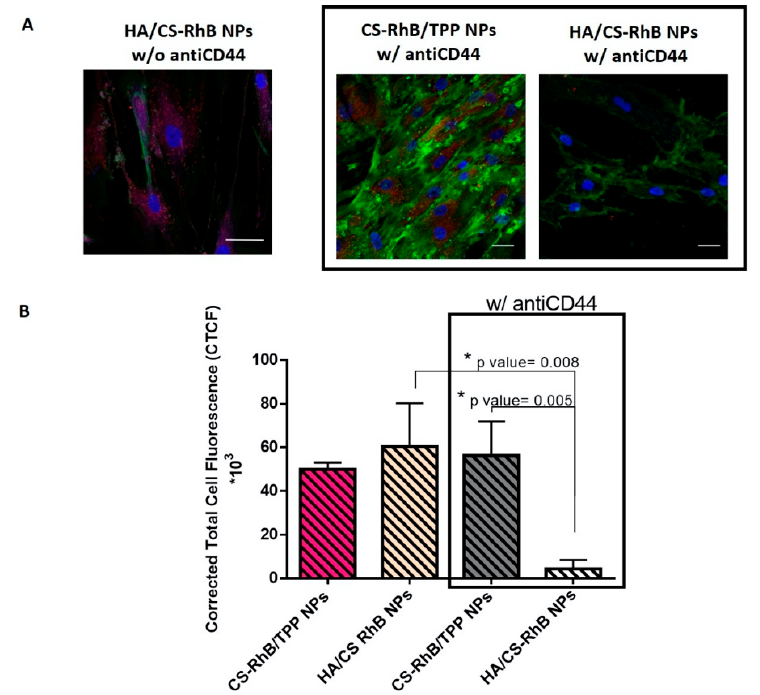
Figure 4. ( A ) Confocal microscopy images of hMSCs incubated with HA/CS-RhB NPs, CS-RhB/TPP NPs (50 μ g/20,000 hMSCs) for 240 min with or without monoclonal antiCD44 primary antibody (scale bar = 20 μ m). ( B ) The red fluorescent intensity of HA/CS-RhB NPs and CS-RhB/TPP NPs localized in the cell cytosol. Results are presented as mean ± SD. Holm-Sidak multicomparison method, * p value < 0.05.